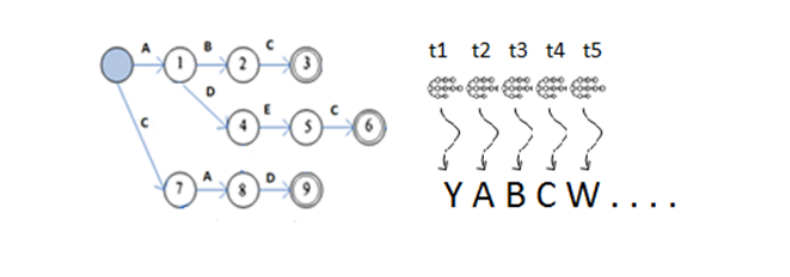
Figure 6: PFAC Finding the patterns with failureless state